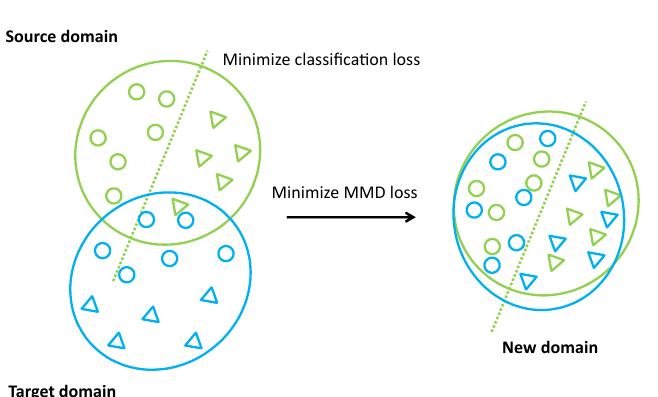
Figure 4: Optimizing an objective that simultaneously minimizes classification error and MMD loss. We use small circles and triangles to denote different labels (unknown in the target domain), and use the dotted line to denote the